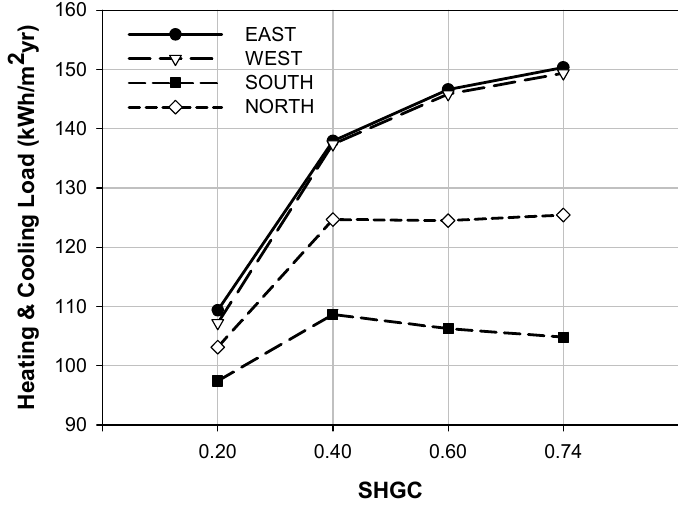
Figure 8. Variation of heating and cooling load with the SHGC.